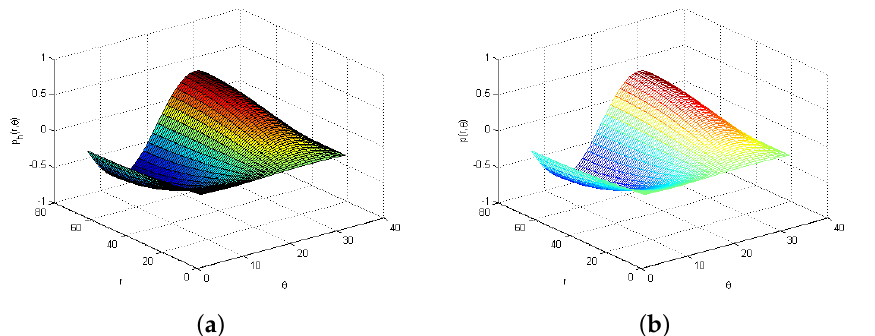
Figure 5. Numerical solution p f